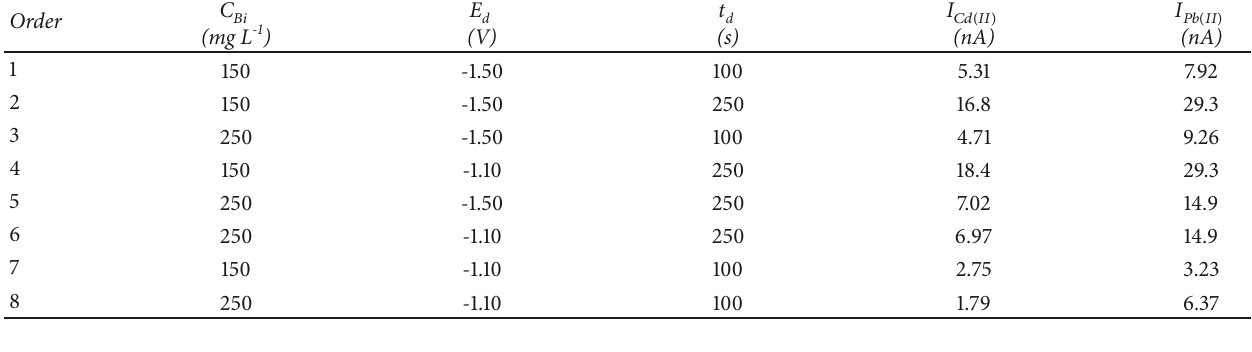
Table 2: Experiments of 2 3 factorial design and response values.